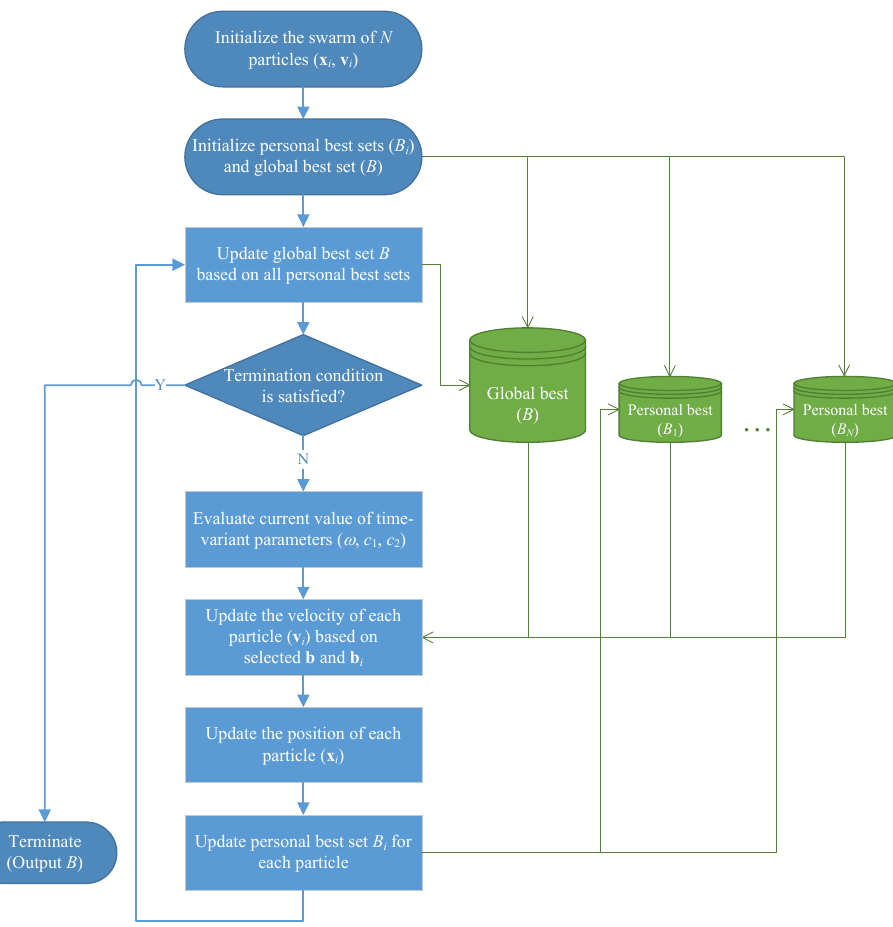
Figure 4. Flowchart of the proposed MOPSO